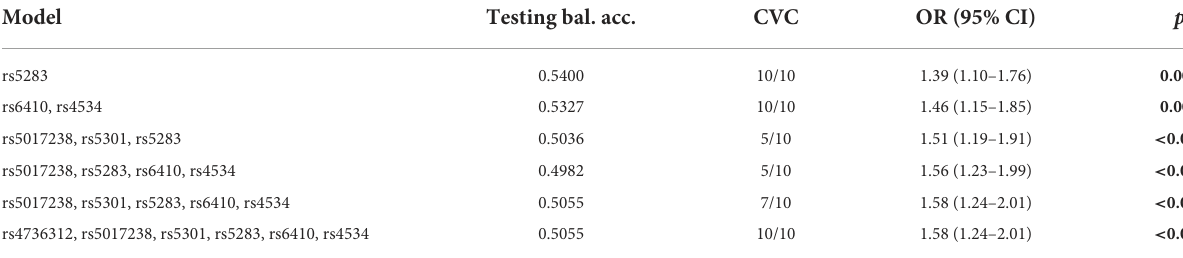
TABLE 7 Best models to predict ischemic stroke by MDR.